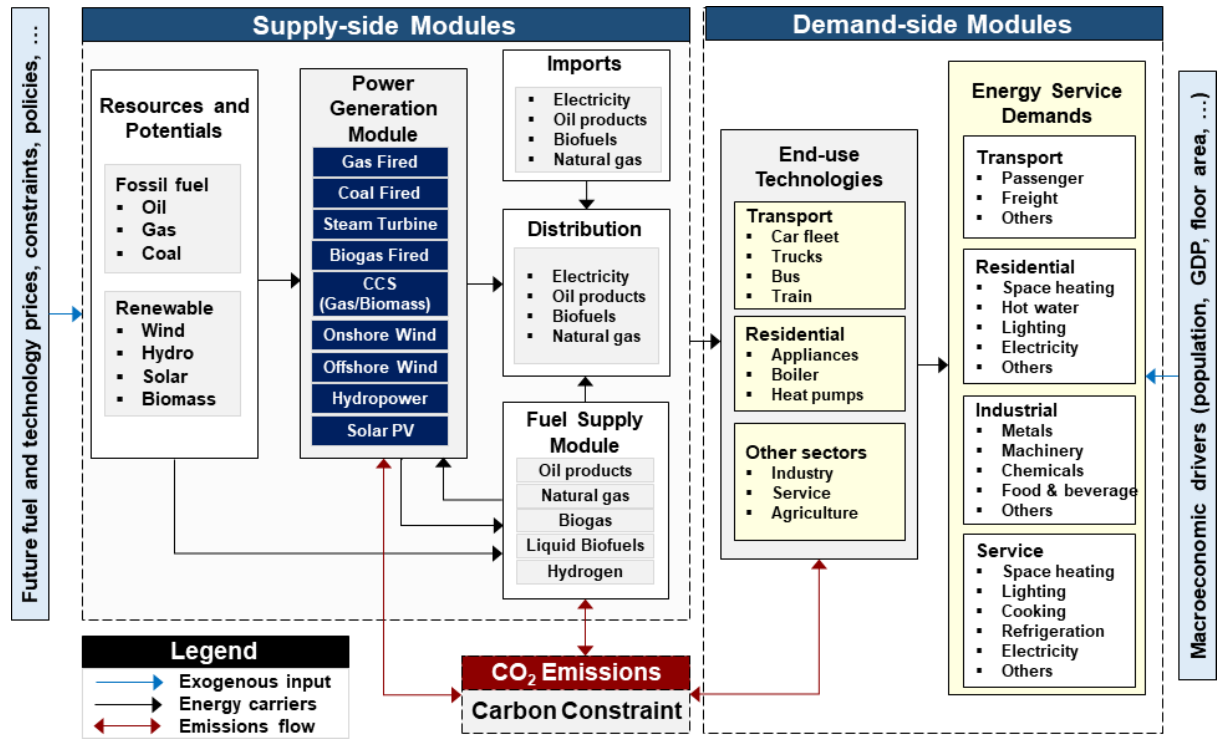
Figure 1. Simplified representation of reference energy system in